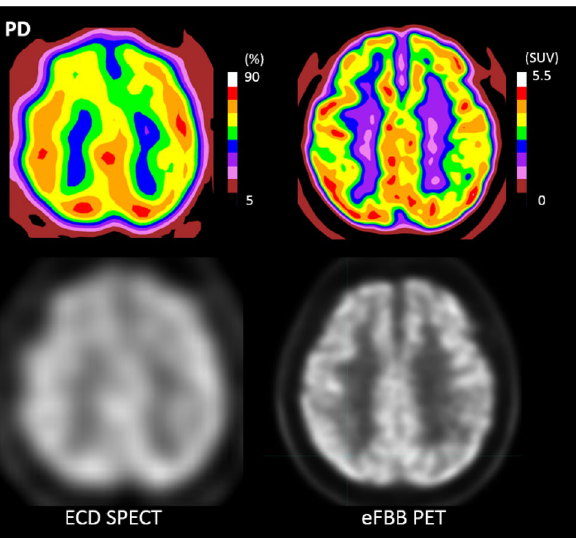
Figure 2. Sample images of ECD SPECT and eFBB PET scans of patients with PD. Sample images are visualized in 10-step colored images (upper row) and grey-scale images (lower row). Abbreviations ECD, Tc-99m ethyl cysteinate dimer; eFBB, early-phase F-18 Florbetaben; PD, Parkinson’s disease; PET, positron emission tomography; SPECT, single photon emission computed tomography; SUV, standardized uptake